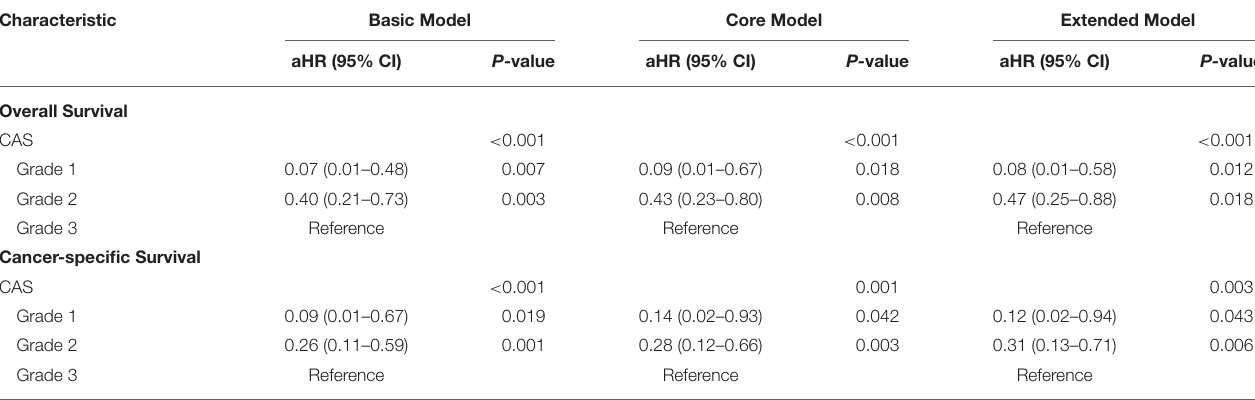
TABLE 4 | Hazard ratios of overall survival (OS) and cancer-specific survival (CSS) was calculated according to CAS in training set a . Characteristic Basic Model Core